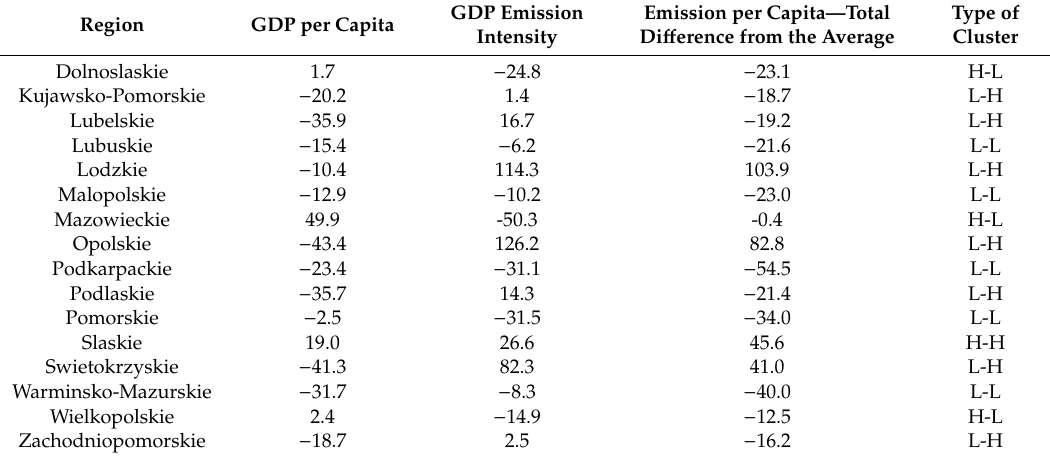
Table 5. Contribution of factors to the total di ff erence in GHG emission per capita [percentage points]. Source: Own